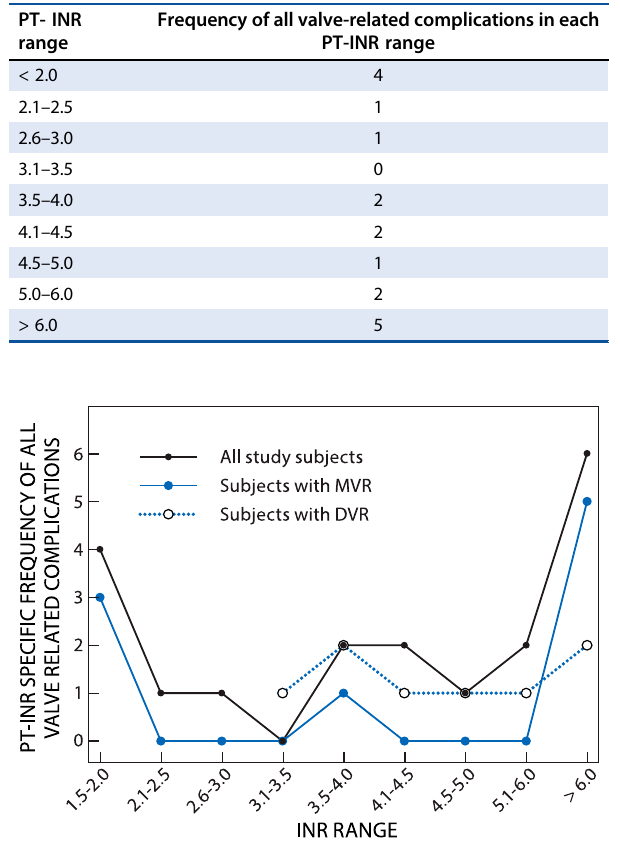
Figure 3: Optimum PT-INR range by the alternative method (only two study subjects with AVR had valve-related complications, hence a mean- ingful curve could not be constructed from the corresponding two points).